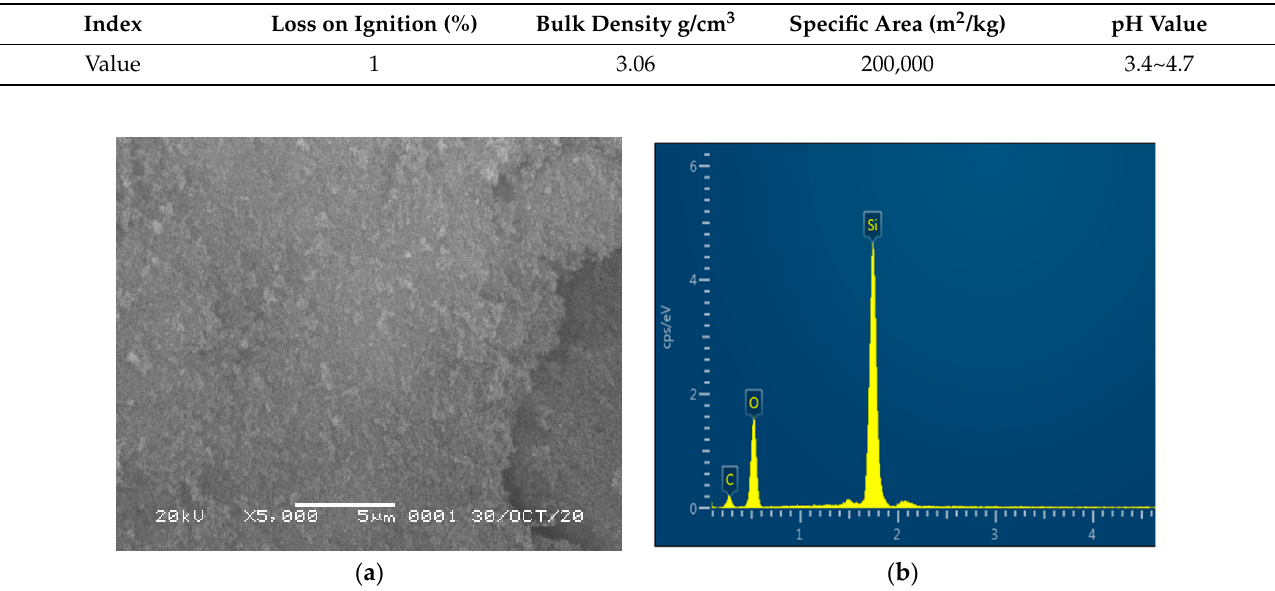
Figure 4. ( a ) SEM, ( b ) EDS. Microscopic characteristics of nano silica.